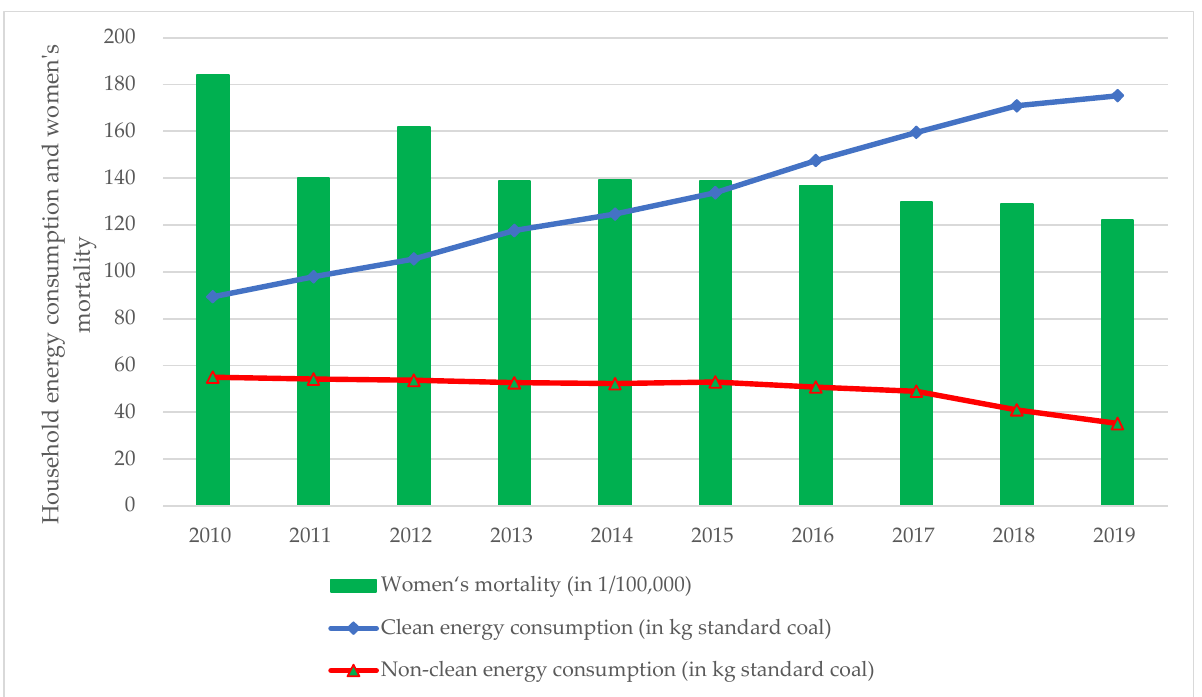
Figure 1. Women mortality due to three prevalent diseases and per capita household energy usage in China (2010–2019). Data source: China National Statistical Yearbook (2011–2020); Note: The 3 prevalent diseases include respiratory illnesses, psychological illnesses and pregnancy illnesses.